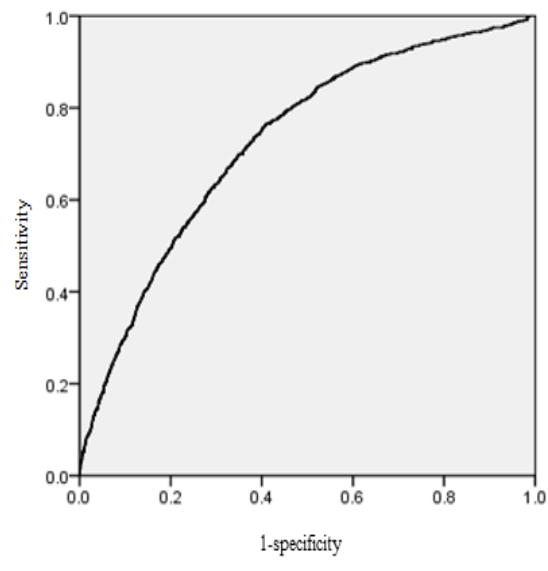
Figure 6. ROC curve of separate mortality